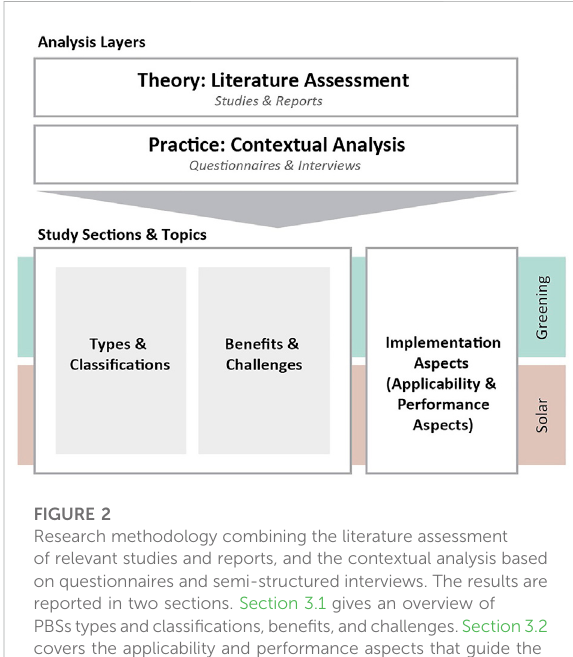
FIGURE 2 Research methodology combining the literature assessment of relevant studies and reports, and the contextual analysis based on questionnaires and semi-structured interviews. The results are reported in two sections. Section 3.1 gives an overview of PBSstypesandclassi fi cations,bene fi ts,andchallenges.Section3.2 covers the applicability and performance aspects that guide the implementation. In both sections, a comparison of the greening and solar systems is